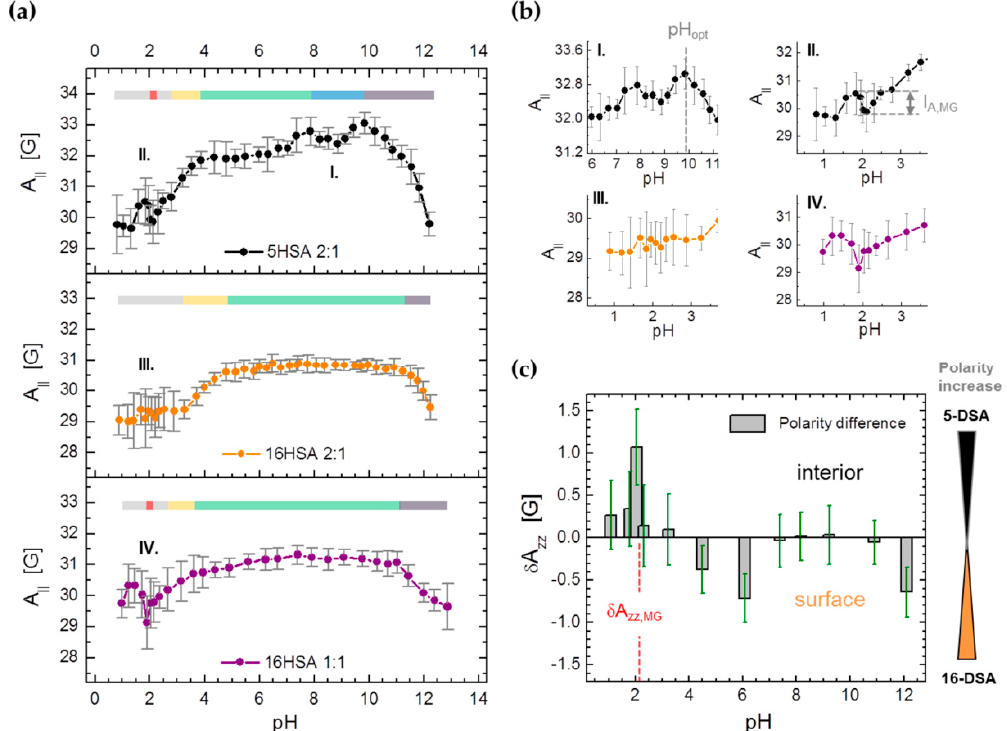
Figure 5. pH ‐ dependence of A || as observed from spin probed HSA. Outer extrema separations 2 A || from CW EPR spectra in Figure 3a–c are plotted in the observed pH range for ( a ) 5HSA 2:1 (black), 16HSA 2:1 (orange) and 16HSA 1:1 (purple) at 400 µ M equivalents. Individual phase spaces containing conformational isomers E, F, C and A are given as a color coded bar at the top of each curve according to Figure 1. Additionally, supposed MG states are given in red bars when a corresponding feature emerges. Significant features are marked with roman numerals (I.–VI.). ( b ) Significant curve features that belong to the pH range of maximum stability (pH opt , I.), or the MG state (II.–IV.) and their corresponding intensity changes ( I A ,MG ) are highlighted, as shown in ( a ). ( c ) A polarity difference plot δ A zz = A zz ,5 − A zz, 16 is constructed from CW EPR spectra that were recorded at T = 150 K (see Supplementary Material S7). Differences in polarity are given as gray columns with green error bars. Positive values indicate a polarity increase for 5-DSA (protein interior) and consistently, negative values indicate a polarity increase for 16-DSA (protein surface) bound to HSA [44]. The maximum change in polarity at about pH 2.0 is denoted with δ A zz, MG . Error bars of ∆ A || (gray) are the calculated relative maximum accuracies from values of individual spectra.